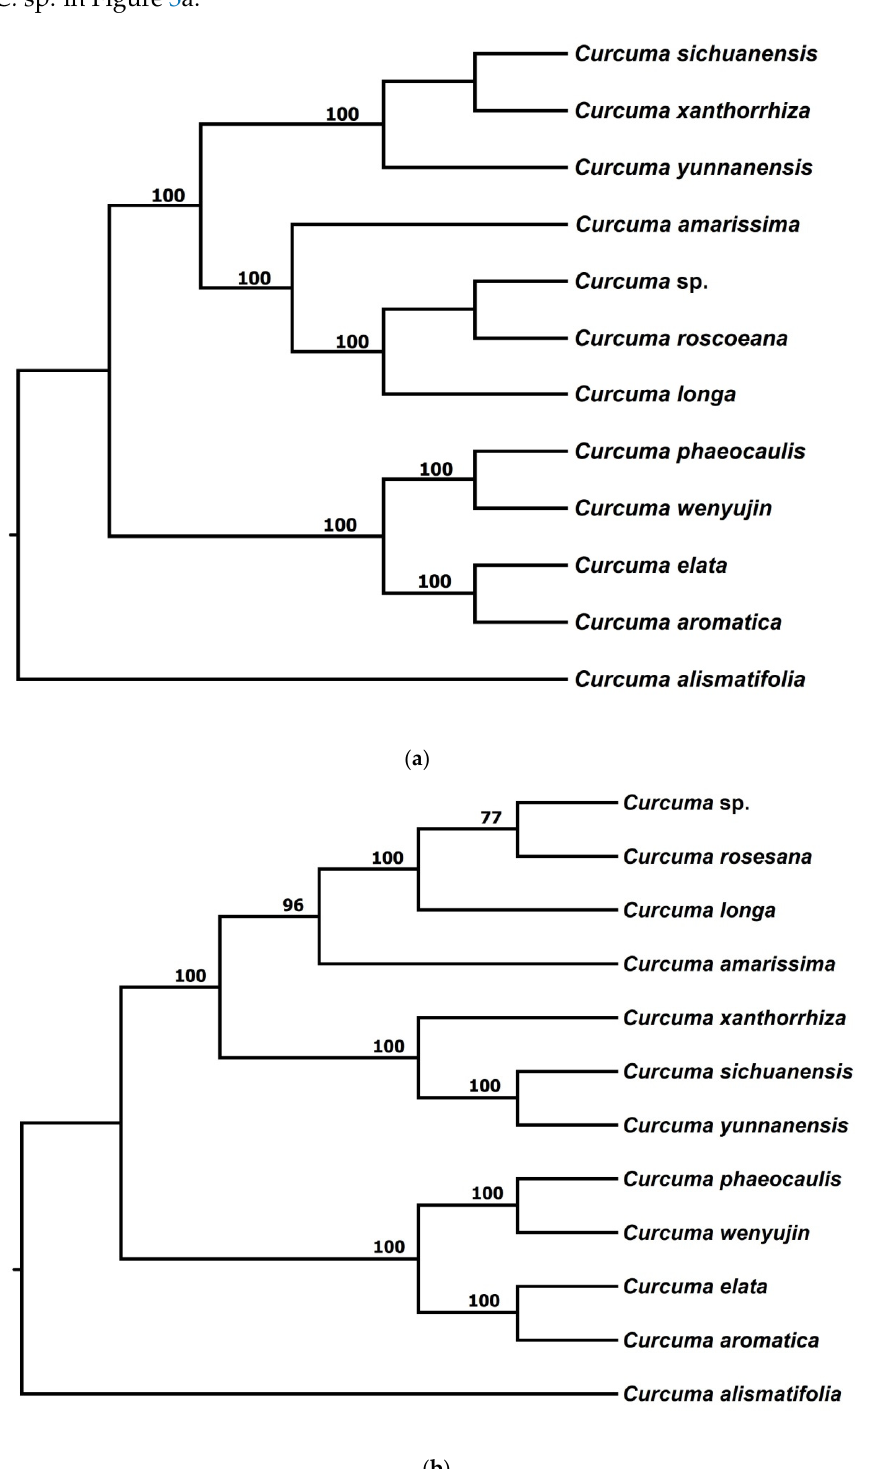
Figure 3. Phylogenetic trees of Curcuma inferring from maximum likelihood (ML) based on the chloroplast genome constructed using ( a ) coding sequence and ( b ) complete chloroplast genome sequence. The maximum likelihood bootstrap values were on the species clade. Only bootstrap values greater than 50 are shown.